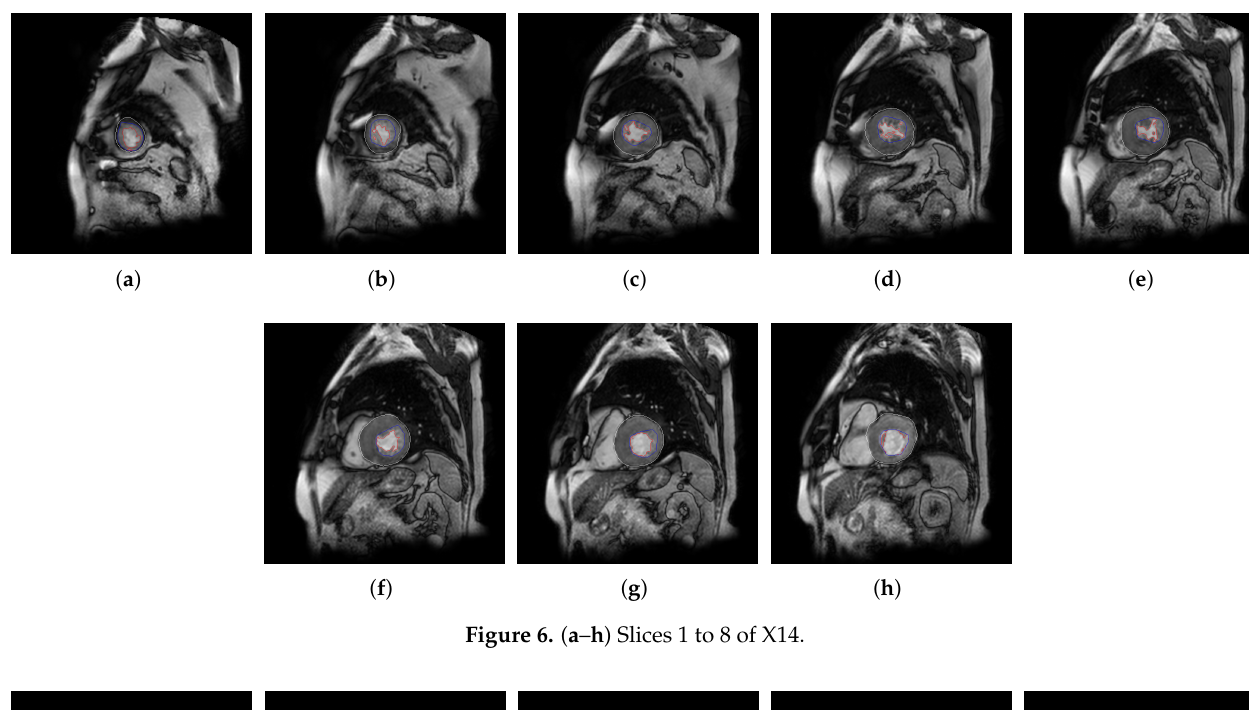
Figure 6. ( a – h ) Slices 1 to 8 of X14.